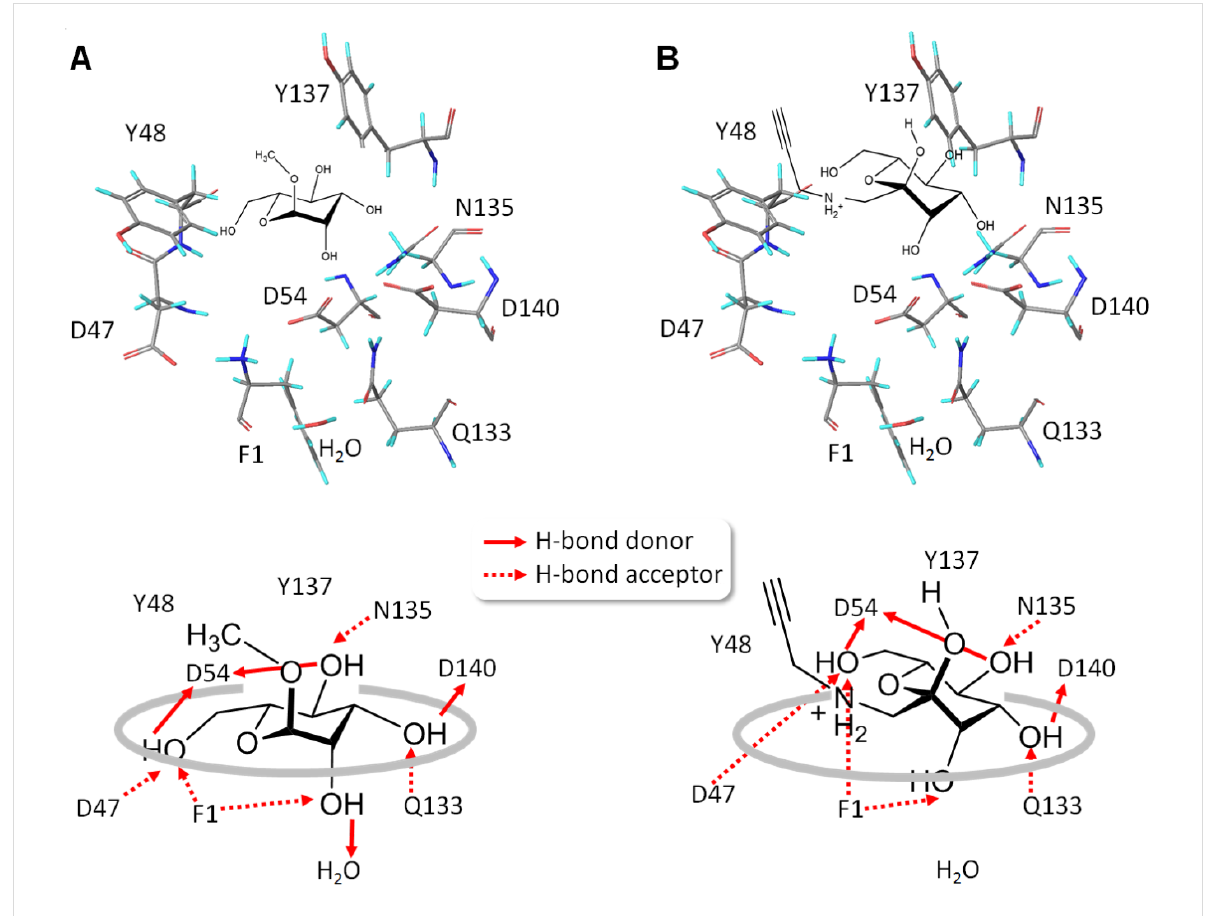
Figure 4: Comparison of mannosides as complexed within the CRD of FimH (PDB 1KLF). A: MeMan ( 1 ); B: Amadori product 9 . The top graphics show the result of the simulated 3D-arrangement of amino acid residues of the FimH CRD with docked 2D-cartoons of MeMan ( 1 , left) and the Amadori product 9 (right). The bottom cartoons are deduced from the docking result illustrating the predicted hydrogen bond network between amino acid side chains and the sugar hydroxy groups (not to